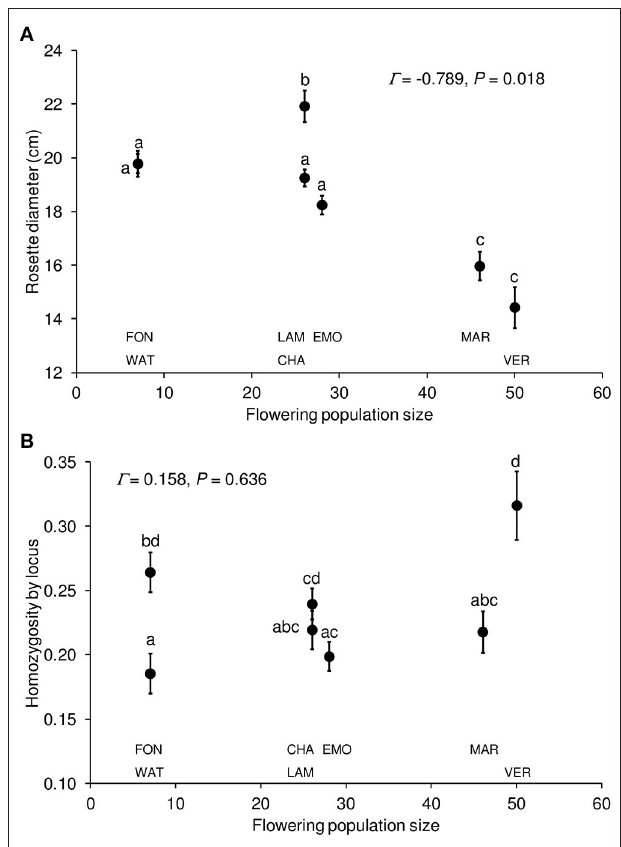
FIGURE 3 | Rosette diameter (A) and homozygosity by locus (B) (mean value ± SE) in function of flowering population size for seven populations (CHA, EMO, FON, LAM, MAR, VER and WAT) of Campanula glomerata . Different letters indicate significant ( P < 0.05) differences based on Tukey tests between populations. Γ = Gamma correlation